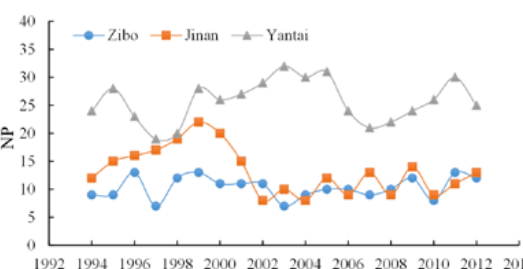
Figure 8. The variation of NP metric of Zibo, Jinan, and Yantai